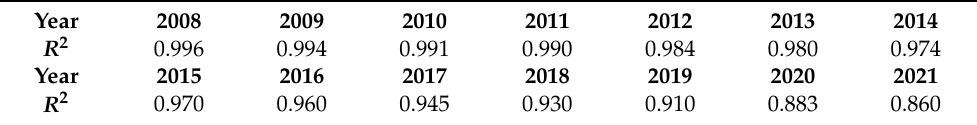
Table 1. Determination coefficients ( R 2 ) corresponding to Figure 3: the historical data of population densities compared with the outcomes obtained with the PPDM analytical solution in Spain in the 2008–201